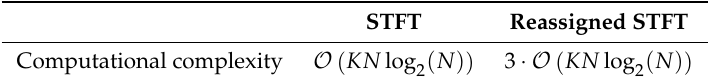
—amount of time instants for which the FFT M / H (cid:100) (cid:101)